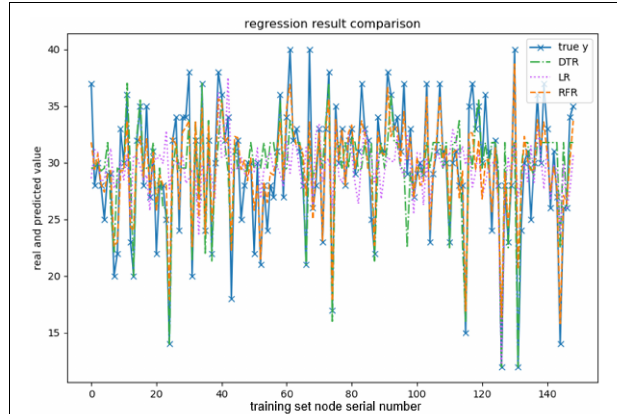
TABLE 6 | Regression index of the neuroticism